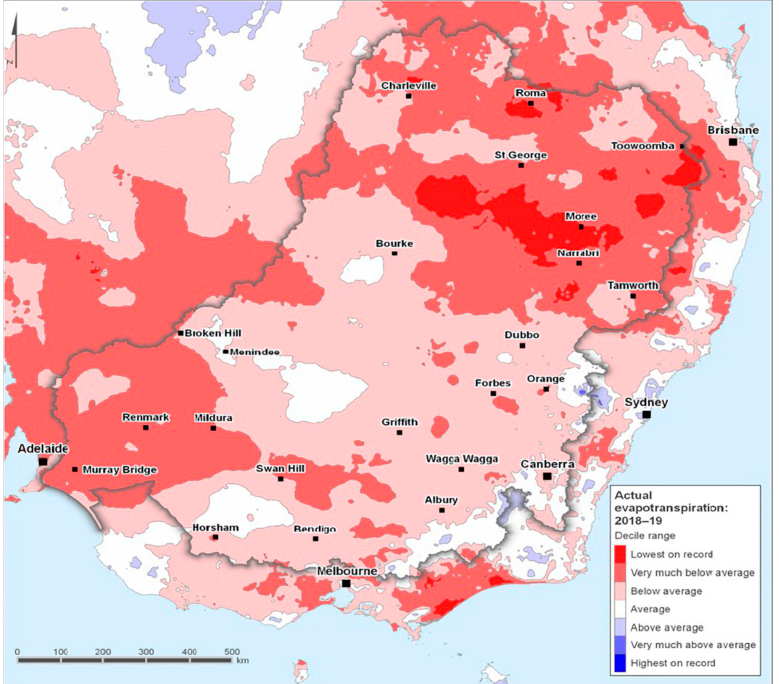
Figure 3. Annual deciles of actual evapotranspiration and soil moisture 2018–2019 . Map of southeast Australia showing deciles for the MDB region during 2018–2019, for annual area-averaged actual evapotranspiration calculated using The Australian Landscape Water Balance Model (AWRA-L v6) [17]. Note the decile area of lowest on record in the NMDB. (Reproduced with permission under Creative Commons Attribution Licence 3.0 from the Australian Bureau of Meteorology. Available at: http://www.bom.gov.au/water/nwa/2019/mdb/climateandwater/climateandwater. shtml (accessed 19 August